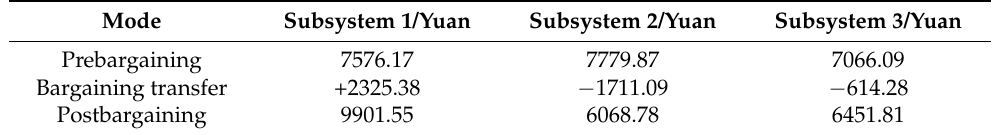
Table 3. Process of each subsystem bargaining under Scenario 3.